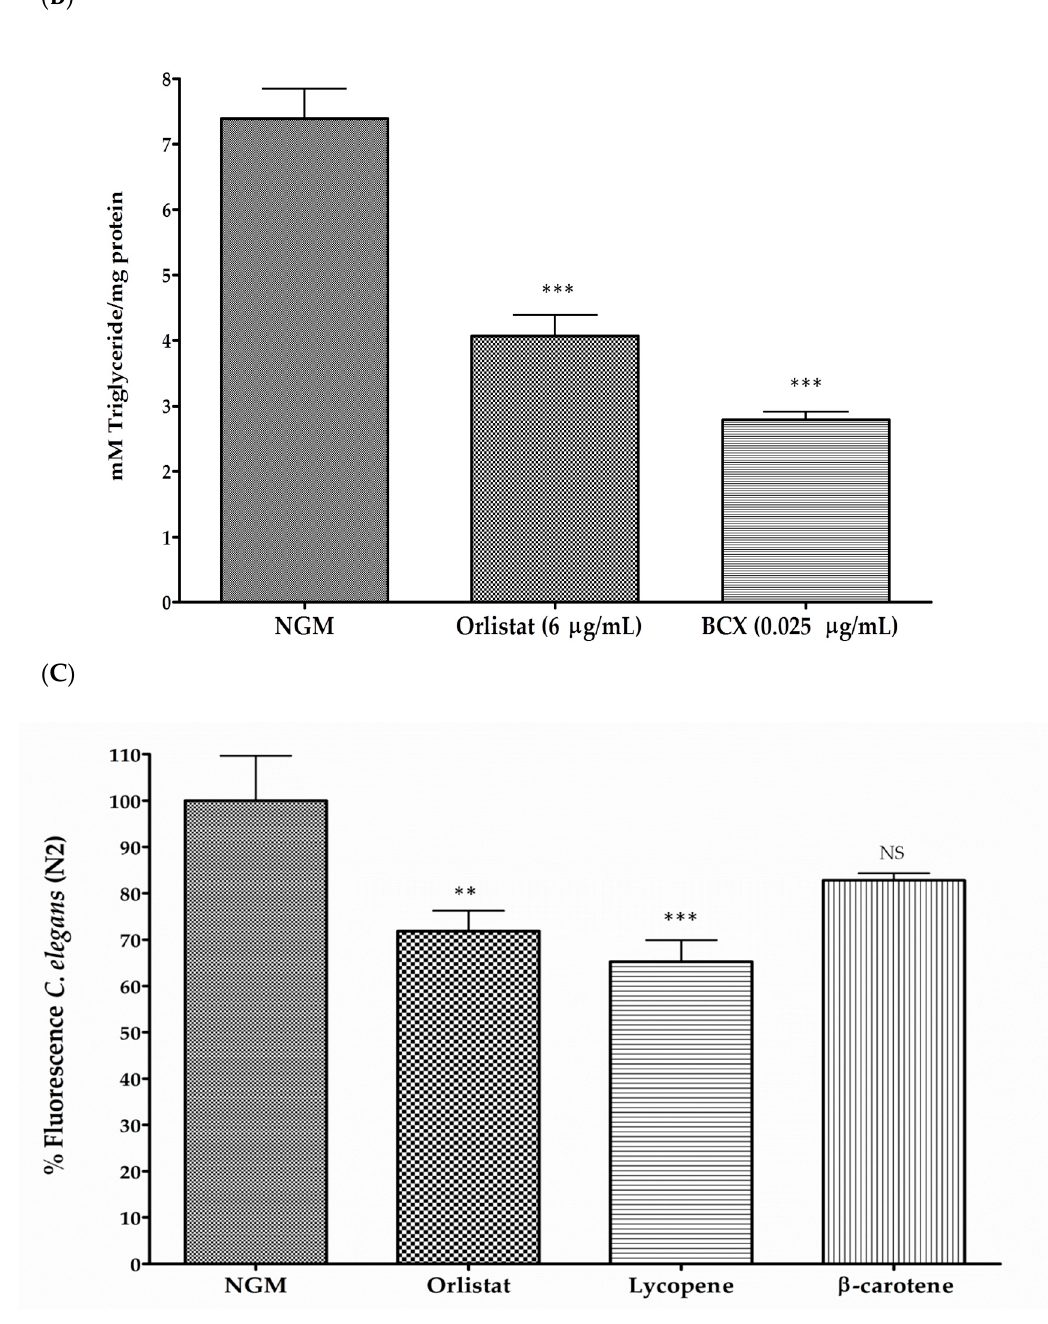
Figure 1. Body fat reduction in Caenorhabditis elegans provided by BCX ( β‐ Cryptoxanthin) and other carotenoids. ( A ) Dose ‐ response Nile Red assay with different doses of commercial β‐ cryptoxanthin. Nematode growth medium (NGM) was used as control feeding condition and Orlistat as positive control. Percentage of fluorescence is the mean of four independent experiments; ( B ) Quantification of triglycerides (TG) content (mM TG/mg protein) in C. elegans fed with BCX (0.025 μ g/mL), Orlistat, and NGM; ( C ) C. elegans were fed with carotenoids lycopene and β‐ carotene at the dose of 0.025 μ g/mL. Data are the average of at least three independent experiments. *** p ‐ value ≤ 0.001, ** p ‐ value ≤ 0.01, NS: not significant.